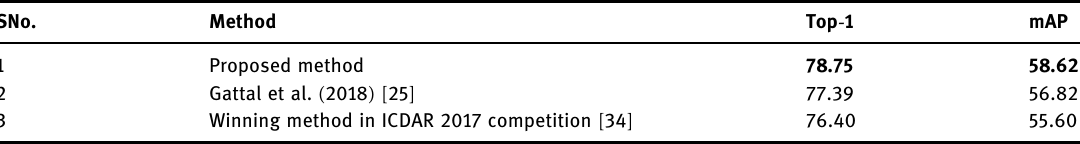
Table 5: Performance comparison with methods using hand - crafted features and evaluated on ICDAR 2017 dataset